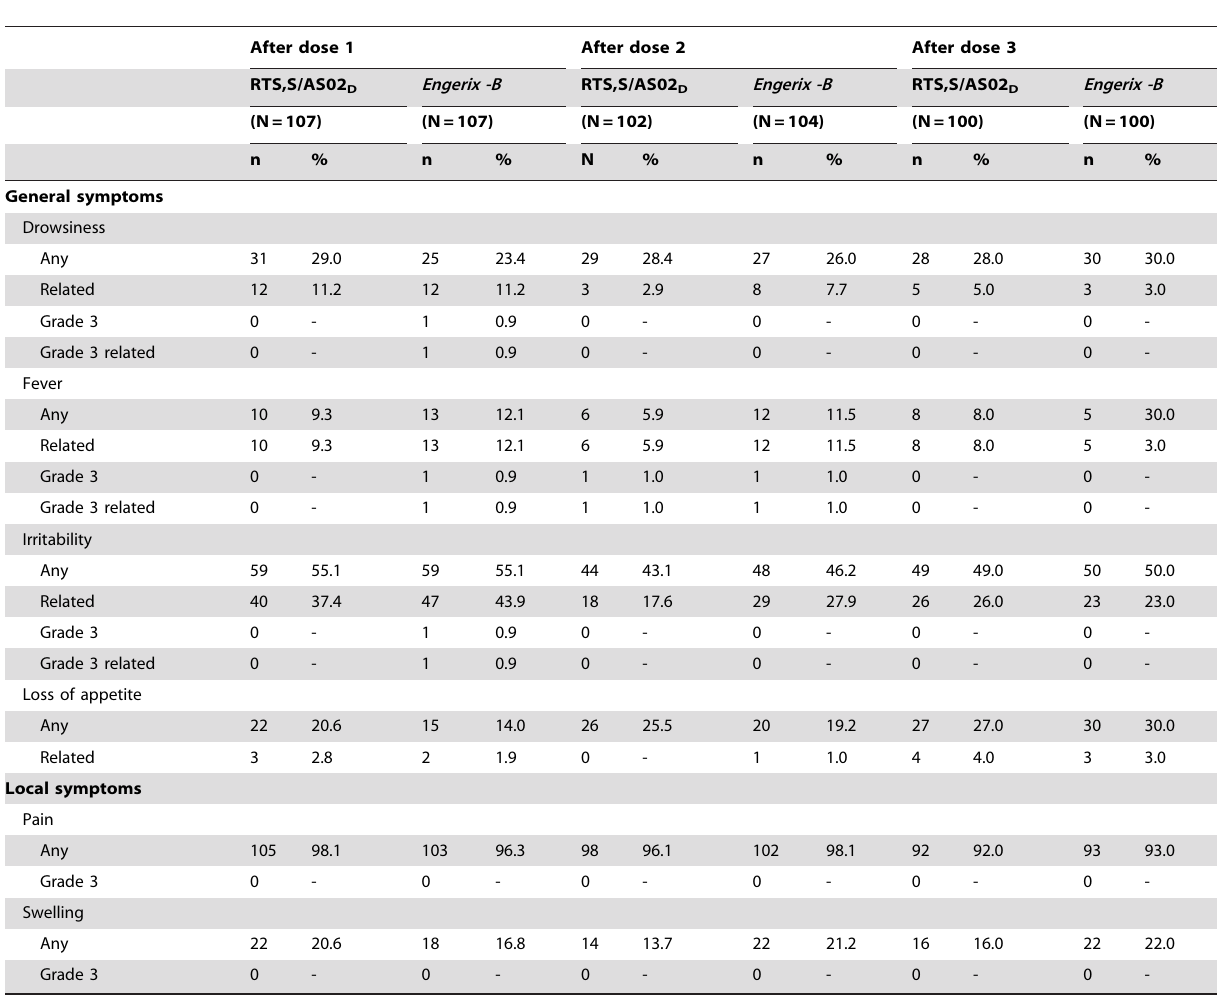
Table 2. Incidence of solicited general symptoms by dose within the 7-days follow-up after TETRActHib TM according to randomization group.